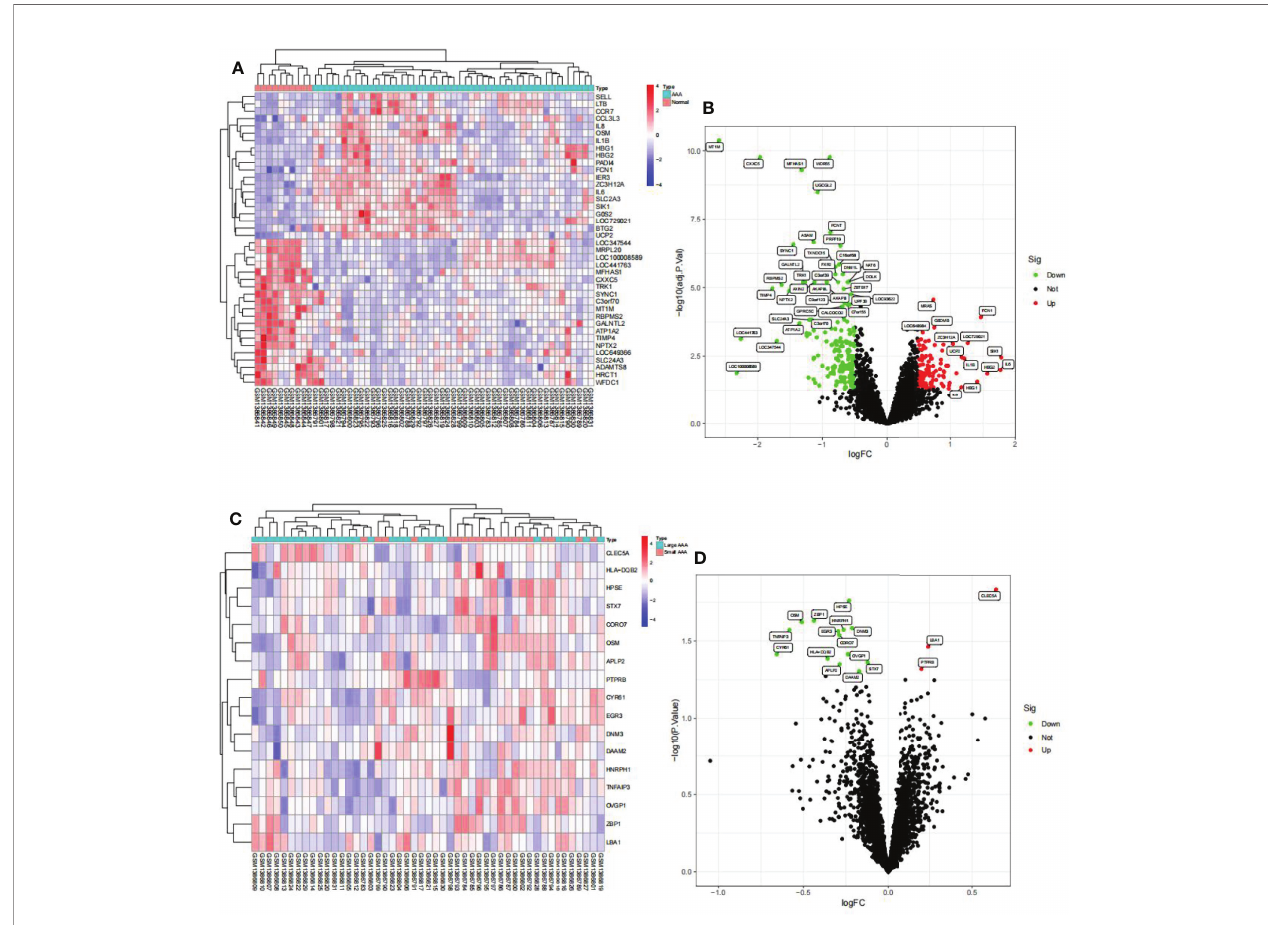
FIGURE 5 | Visualization of the DEG fi ndings in GSE57691. (A) Heatmap clustering of genes with markedly different expression in AAA compared normal samples. |log2Foldchange|>0.5 and adjusted P-value < 0.05 were used to de fi ne statistically signi fi cant DEGs. AAA: abdominal aortic aneurysm; DEGs, differentially expressed genes. Cyan denotes AAA samples, whereas red-orange denotes normal samples. (B) DEGs volcano map; red denotes upregulated genes, black represents genes with no signi fi cant difference, and green represents downregulated genes. (C) Heatmap clustering of genes with substantially different expression levels in large AAA compared small AAA samples. P-value < 0.05 was used to determine statistically signi fi cant DEGs. AAA: abdominal aortic aneurysm; DEGs, differentially expressed genes. Cyan indicates large AAA samples, whereas red-orange indicates small samples. (D) DEG volcano map; red denotes upregulated genes, black represents genes with no signi fi cant difference, and green represents downregulated